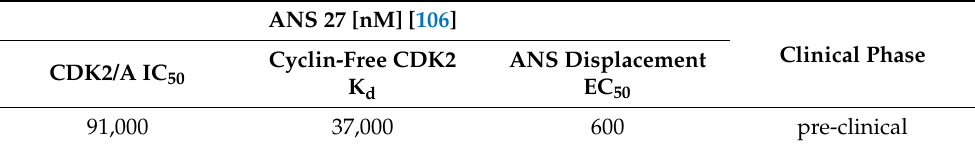
Table 5. Selected biological data obtained from different experiments with ANS which demonstrate that it targets monomeric CDK2.